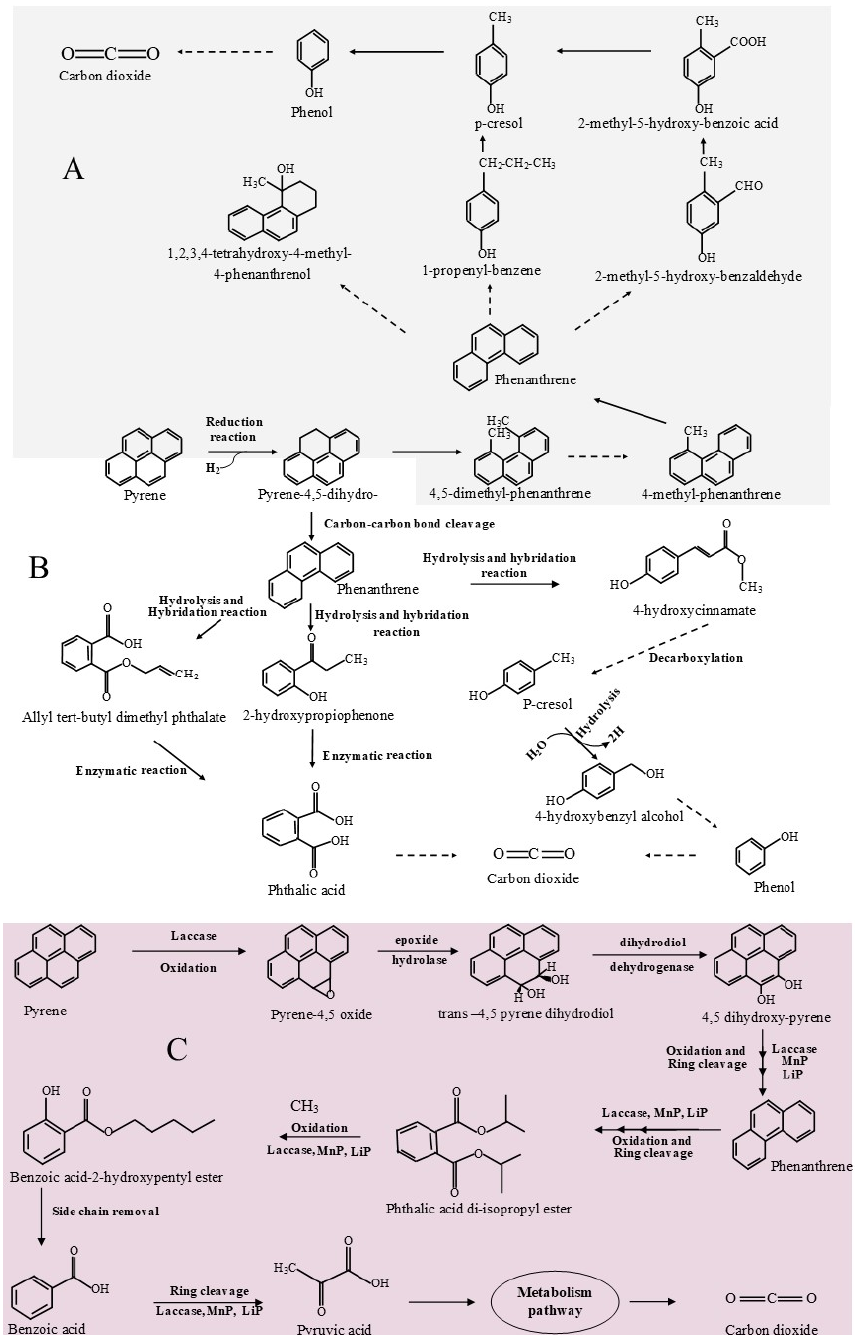
Figure 2. Pyrene anaerobic degradation pathway by Pseudomonas sp. JP1 ( A ), Klebsiella sp. LZ6 ( B ), and Coriolopis byrsina APC5 ( C ). Solid and dashed arrows represent, respectively, single and multiple steps (adapted, respectively, from Liang et al. [62]; Li et al. [61] and Agrawal and Shahi [63]).